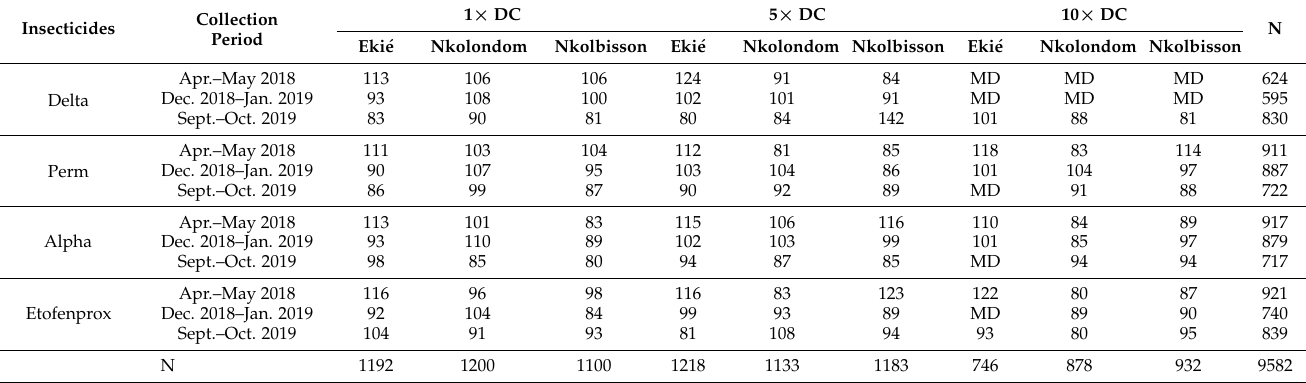
Table 4. Number of mosquitoes used for insecticide susceptibility and resistance intensity